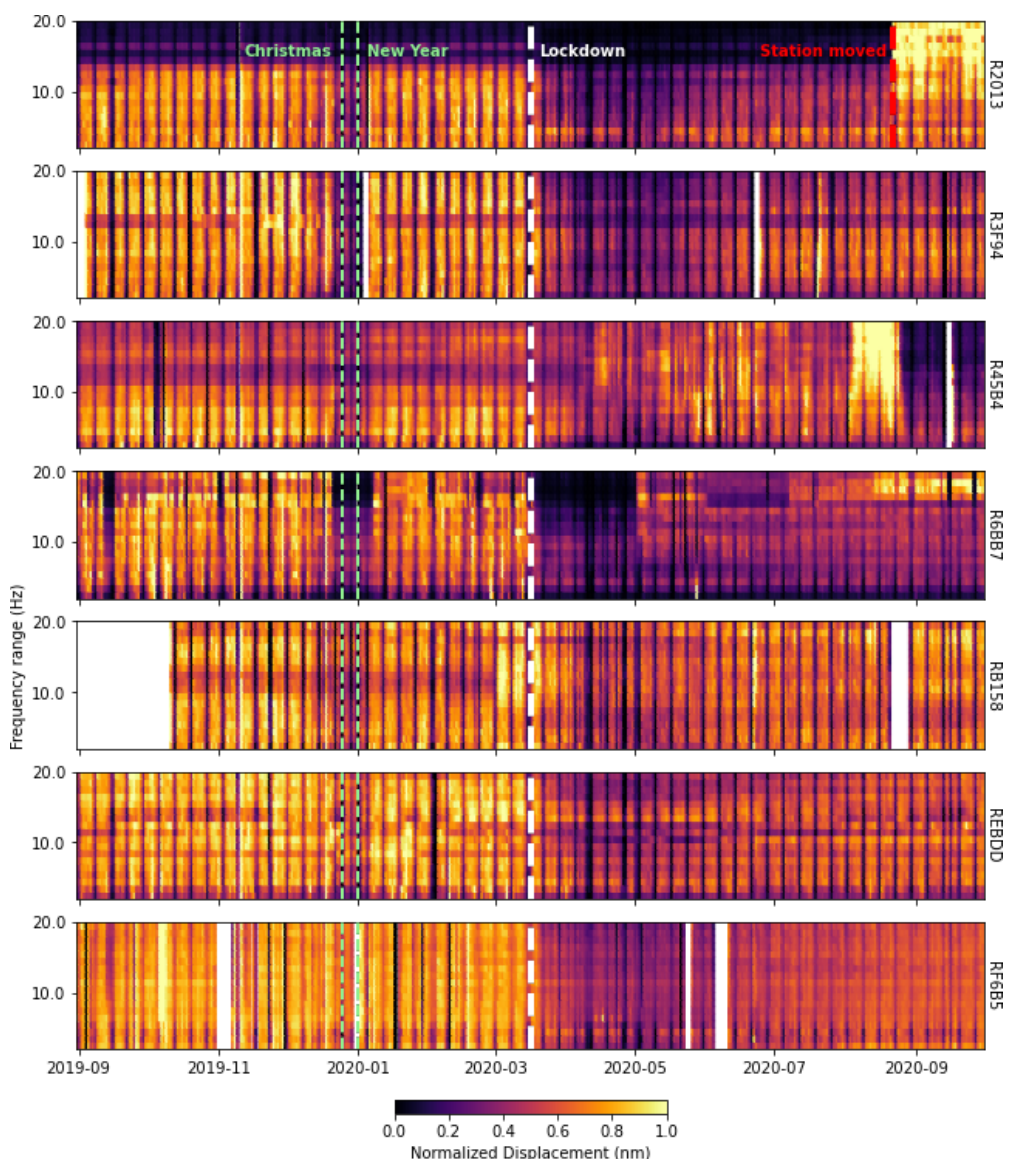
Figure 2. Normalized variation of rms displacement in 1Hz frequency bins from 1 to 20Hz at all stations. The typical succession of business days and weekends can clearly be observed, but the largest reductions in seismic noise levels are identified during the Christmas holiday (green dashed lines are Christmas and New Year, respectively) and following the implementation of lockdown measures in mid-March 2020 (white dashed line). Note that station R2013 was moved in late August 2020 (red dashed